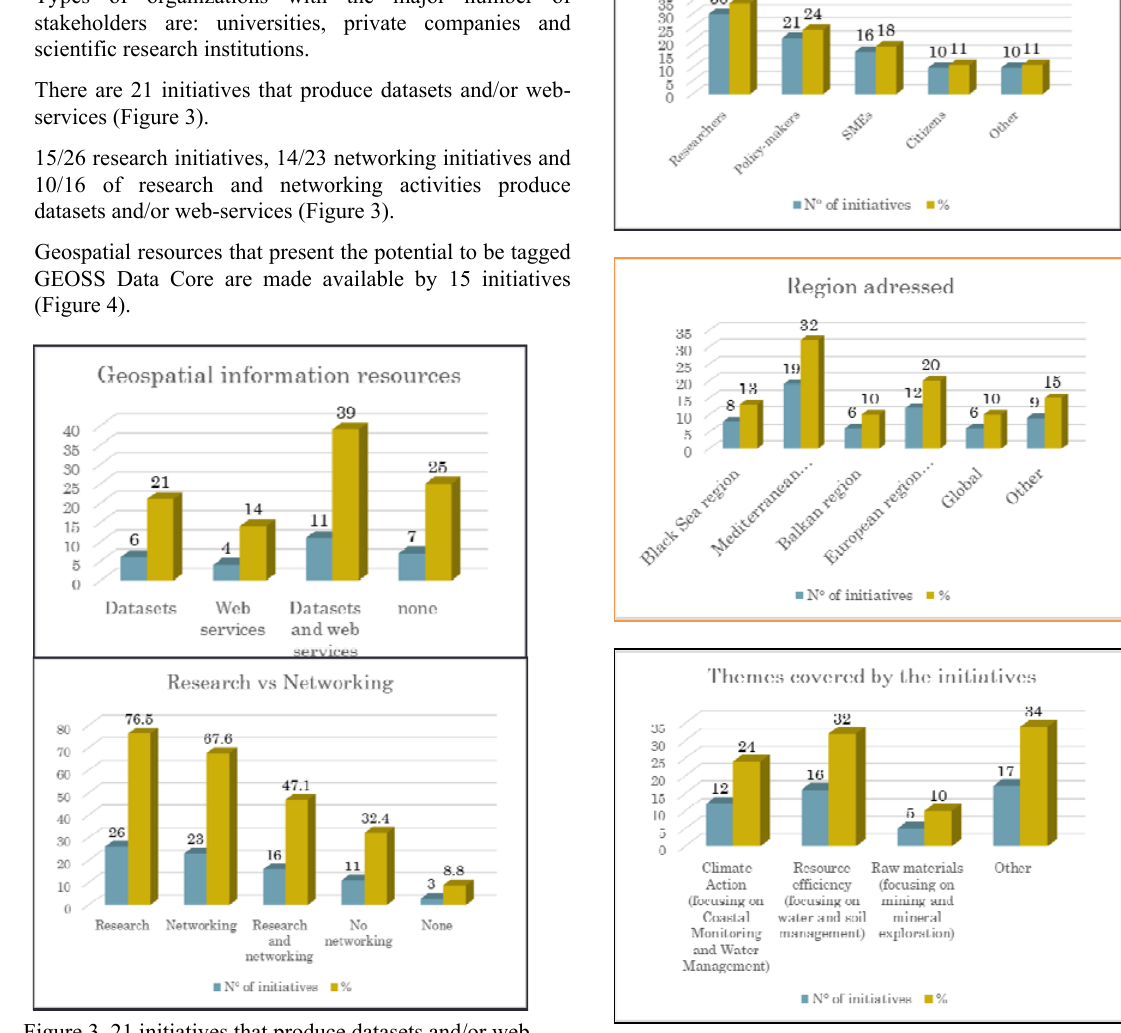
Figure 5. Other major